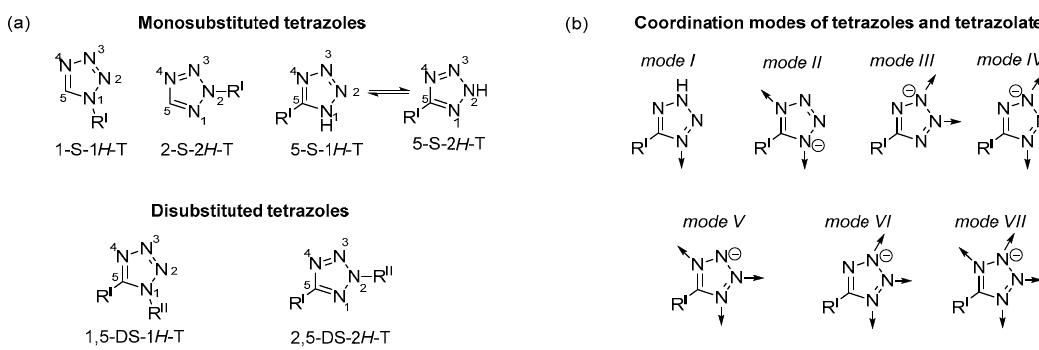
Figure 1. ( a ) Substitution patterns of tetrazoles. ( b ) Coordination modes of tetrazoles and